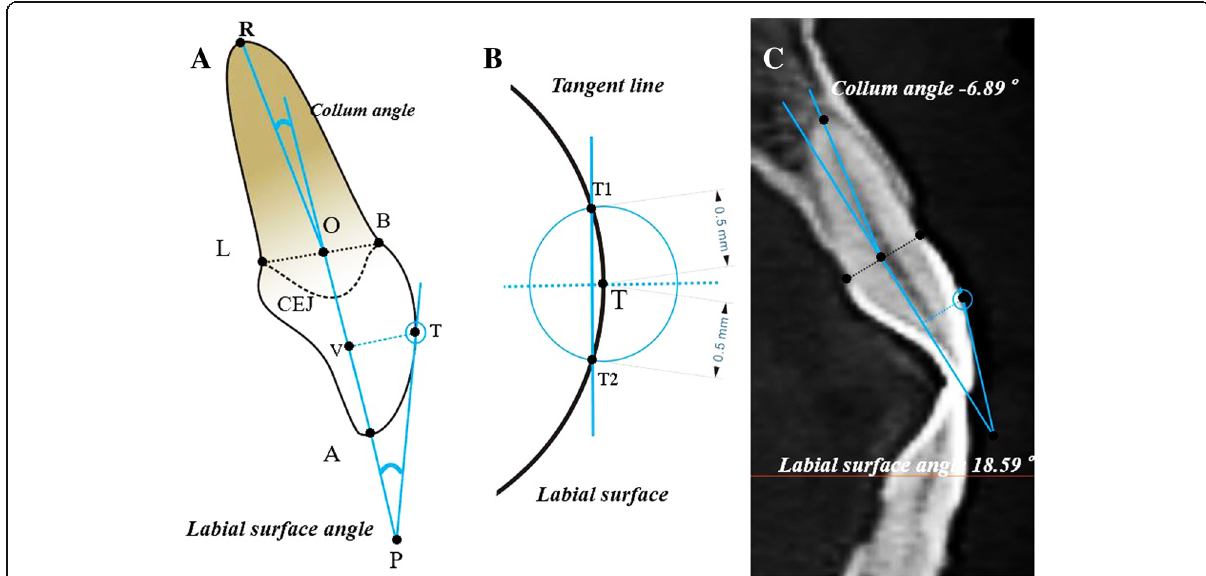
Fig. 4 a The Collum angle is formed by the extension of the long axis of the crown and the long axis of the root. b Tangent L passes through upper and lower intersections of labial surface of crown and circle with the T center and radius of 0.5 mm. c The measuring example of Collum angle and labial surface